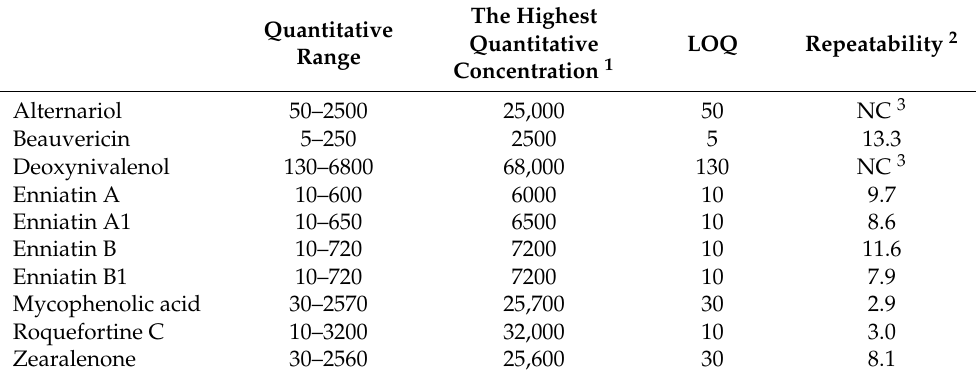
Table 1. Quantitative range of calibration curve ( µ g/kg), the highest quantitative concentration ( µ g/kg), limit of quantification (LOQ, µ g/kg) and repeatability (%) of detected mycotoxins. The Highest Quantitative Quantitative LOQ Repeatability 2 Range Concentration 1 Alternariol